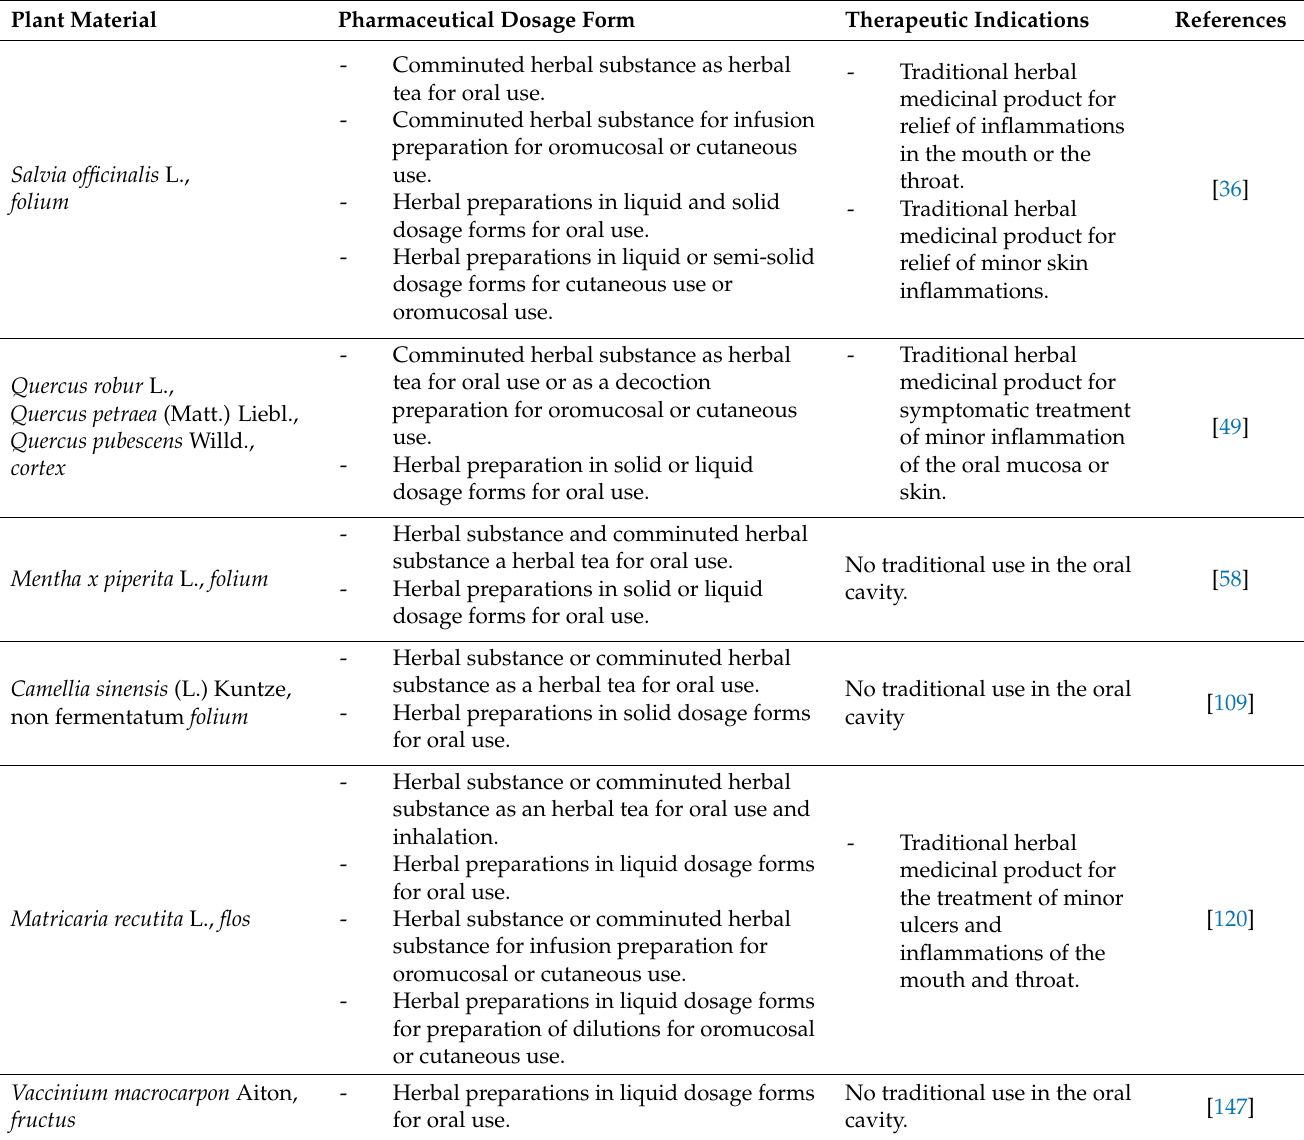
Table 1. Traditionally-used pharmaceutical dosage forms and therapeutic indications of selected plant materials according to European Union herbal